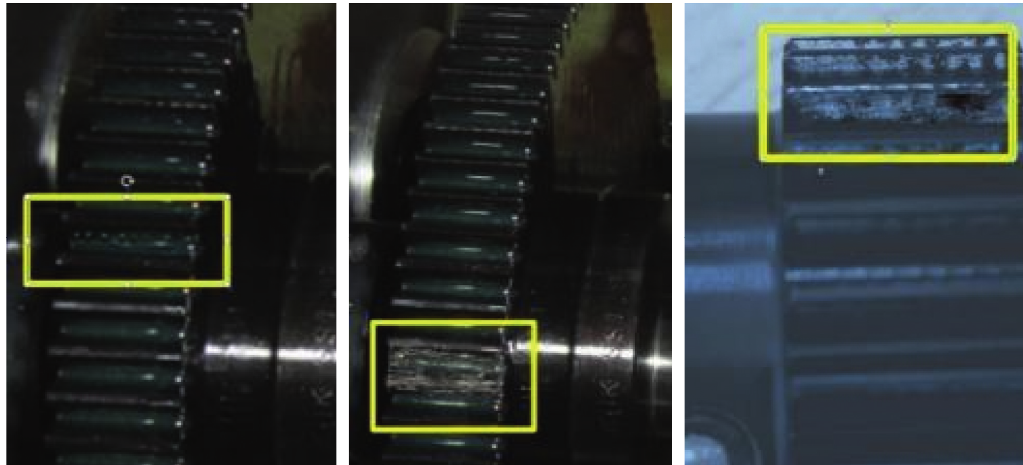
Figure 8: Fault pattern of the gears which are pitting, tooth fracture, and wear.